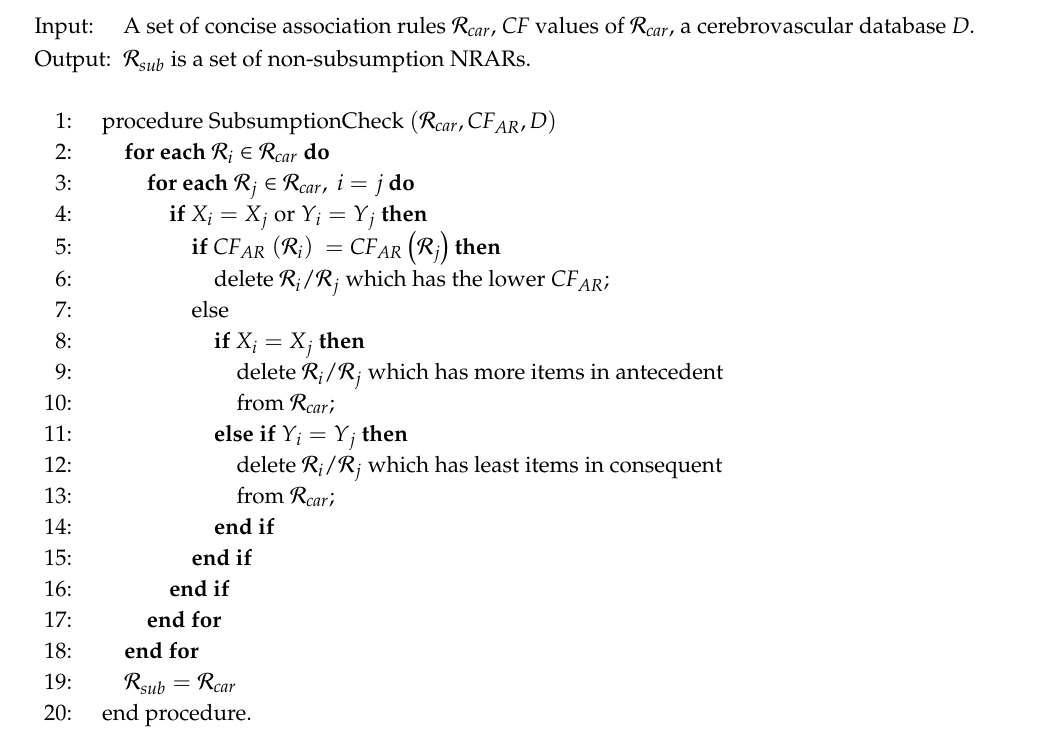
Algorithm 2 Building Non-subsumption